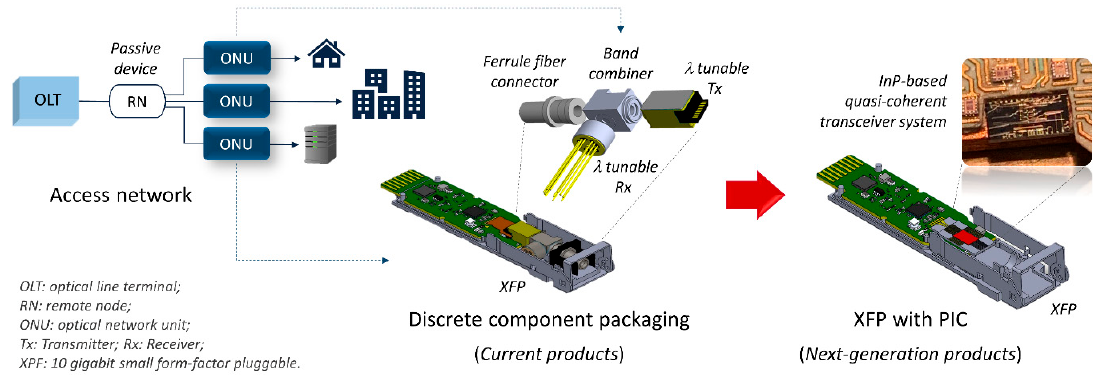
Figure 4. Diagram describing the evolution of photonic integrated circuits (PIC) for PON, specifically the implementation of a bi-directional optical sub assembly (BOSA) transceiver solution in PON ONU side, i.e., XFP with discrete optical component packaging (current PON products) and with PIC approach technology (next-generation products).